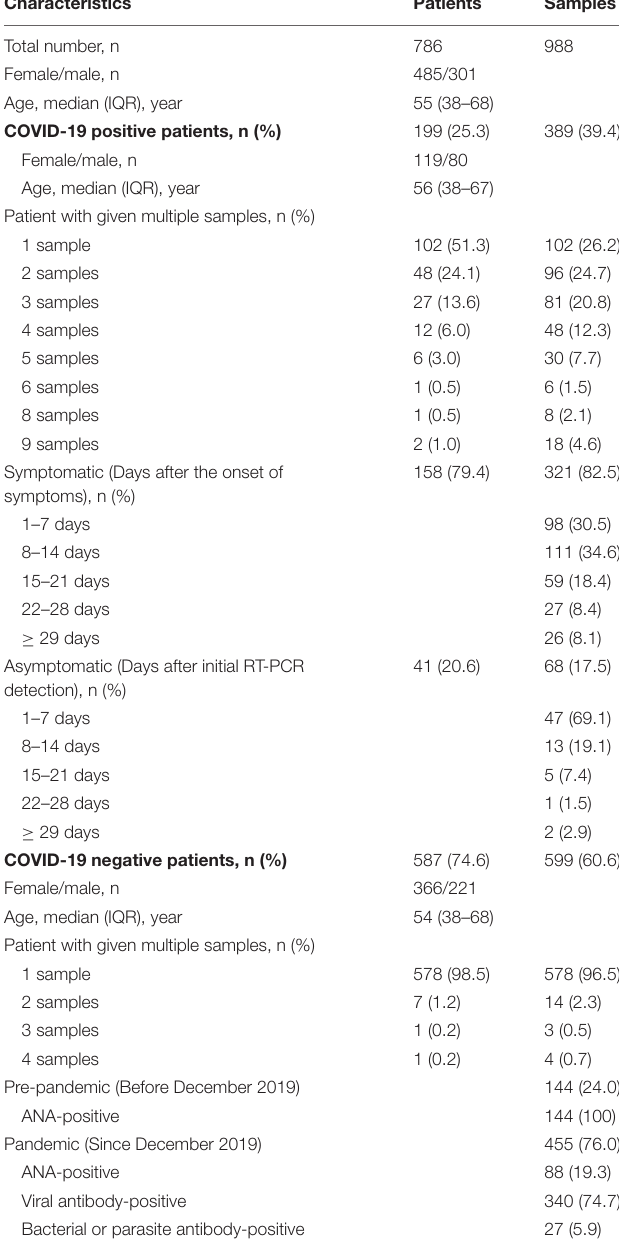
TABLE 2 | Characteristics of samples tested for SARS-CoV-2 antibody assays in this study.